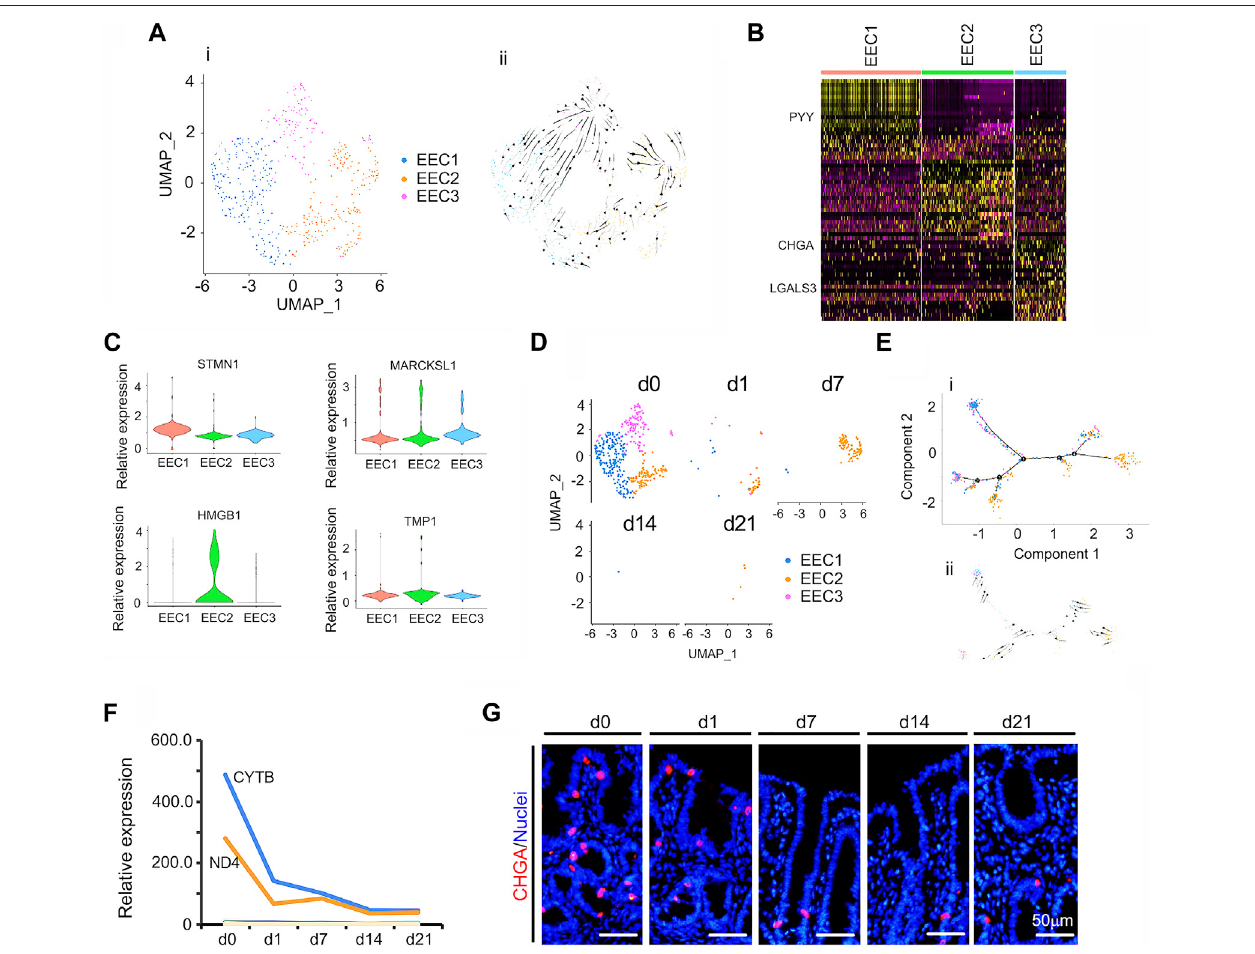
FIGURE6| SummaryofscRNA-seq dataforEECs. (A) CelltypeclustersforEECsforthecellstogetherfromthe fi vetimepointsbyUMAP.(i)UMAPofEECssingle cells (points), colored by clusterassignment. (ii) RNA velocity vector projection on UMAP plots (The arrow indicated thedevelopmental trend). (B) Heatmap ofthe top 25 marker genesin each cluster ofEECs. (C) Expressionpatternofmarker genes indifferentEECs clusters. (D) EECs population decrease during development(fromd0 to d21). (E) EECs trajectory reconstruction based on cell clusters following pseudotime analysis. (i) Monocle plot. (ii) RNA velocity vector projection on a monocle plot (The arrow indicated the developmental trend). (F) The relative expression pattern of the top 50 speci fi cally expressed genes in EECs. The gene level was based on the expression of each gene in all the cell, and it is relative level from scRNA-seq analysis. The Y-axis presents the relative expression, and X-axis shows the time points. (G) Protein levels of CHGA in different samples at different time points according to IHF. Scale bar: 50 μ m.